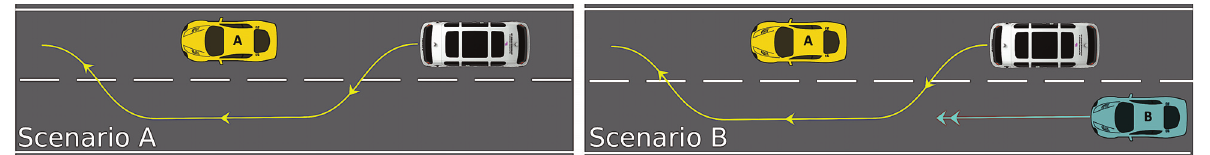
Fig. 8. Two different scenarios for